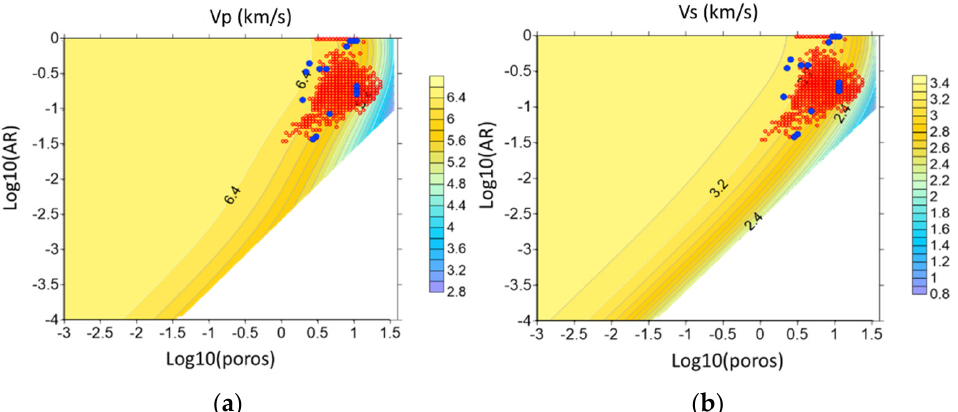
Figure 4. ( a ) Compressional and ( b ) shear wave velocities for a model of calcite matrix with randomly oriented brine-saturated voids versus decimal logarithms of porosity (poros) and void’s aspect ratio (AR). Red signs show values for West Siberian limestones. Blue signs are used for limestones from layers within a shale formation [54].